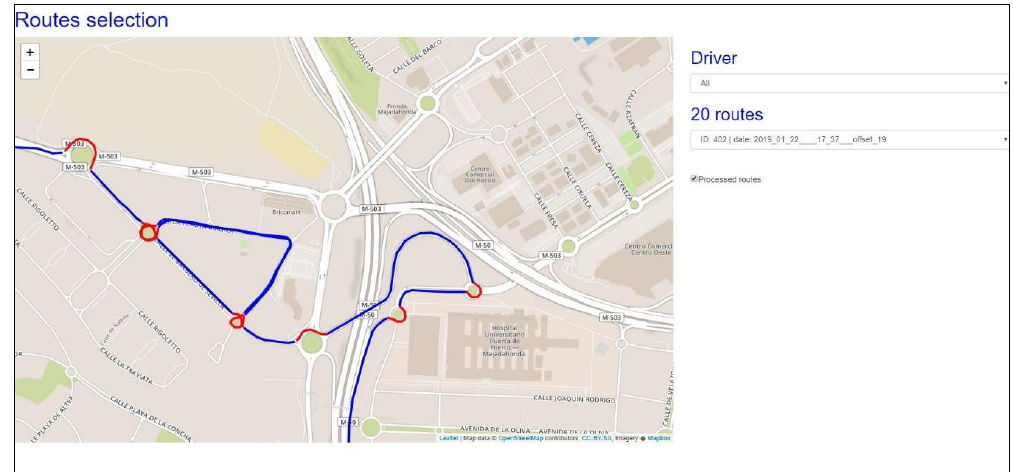
Figure 7. View of the vehicle’s status in the application. Specifically, the information regarding data captured by the Arduino board (steering wheel rotation, pedal status, intermittent, and auxiliary buttons) as well as data from the Smartphone ’ s accelerometer are shown.